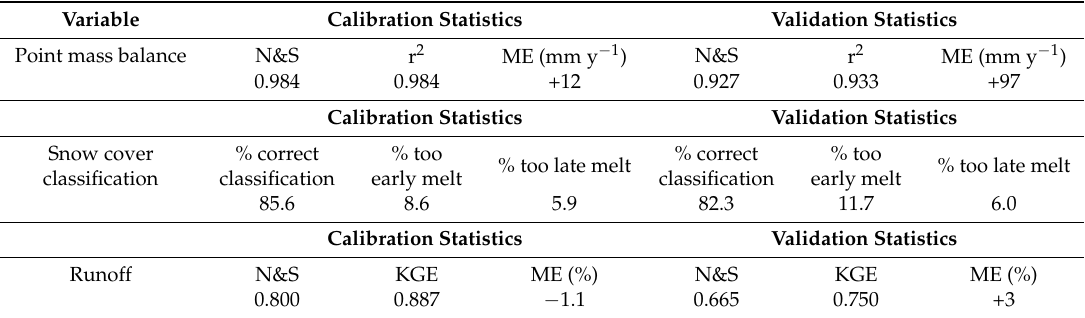
Table 4. Results of EISModel 4.0 calibration and independent validation tests. KGE is the Gupta et al.’s [45]